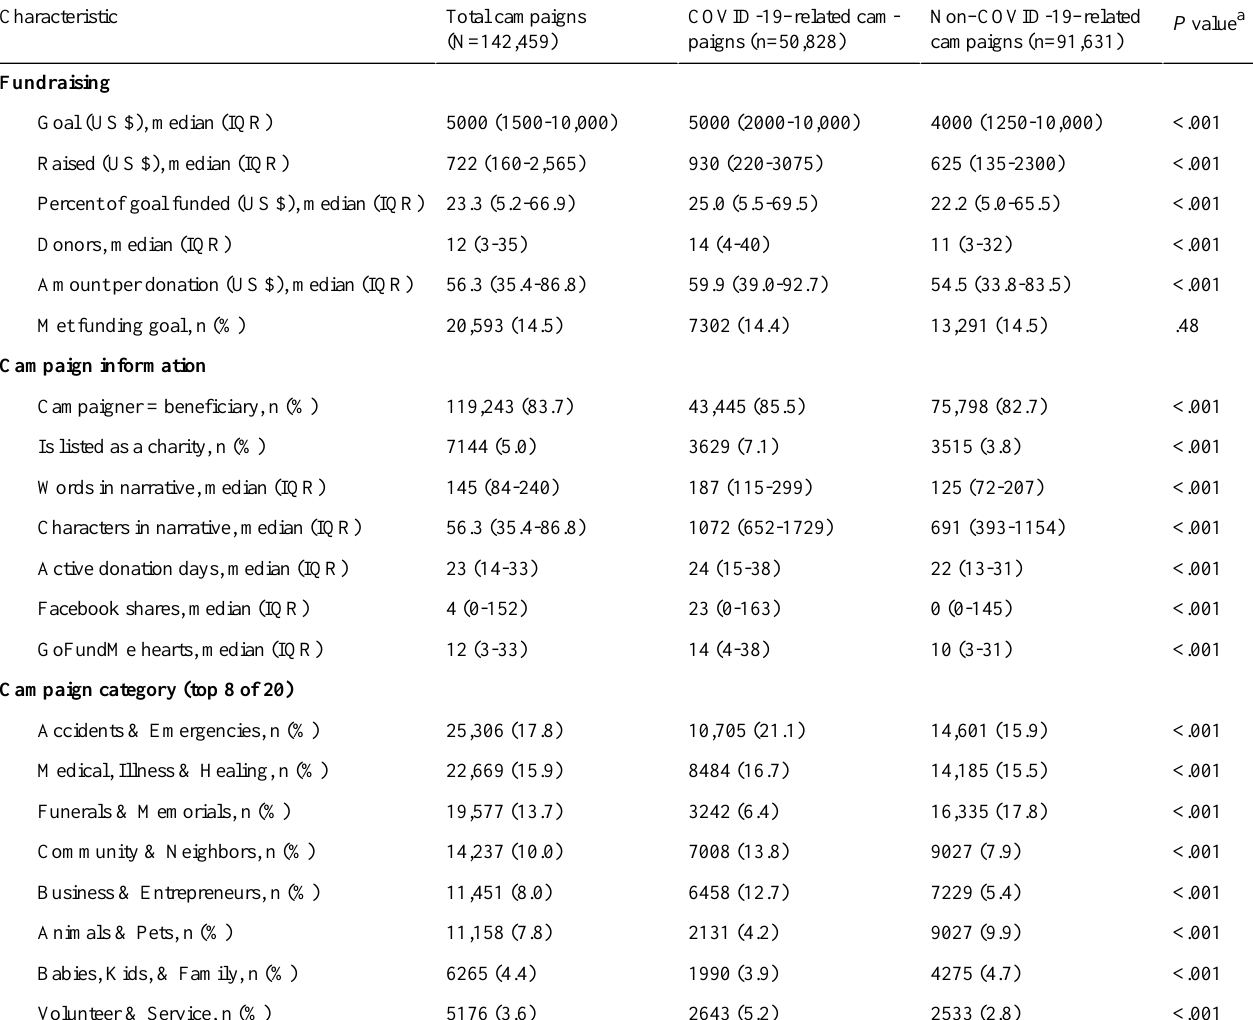
Table 1. Baseline GoFundMe campaign characteristics stratified by COVID-19–related status. Only campaigns created after March 11, 2020, are